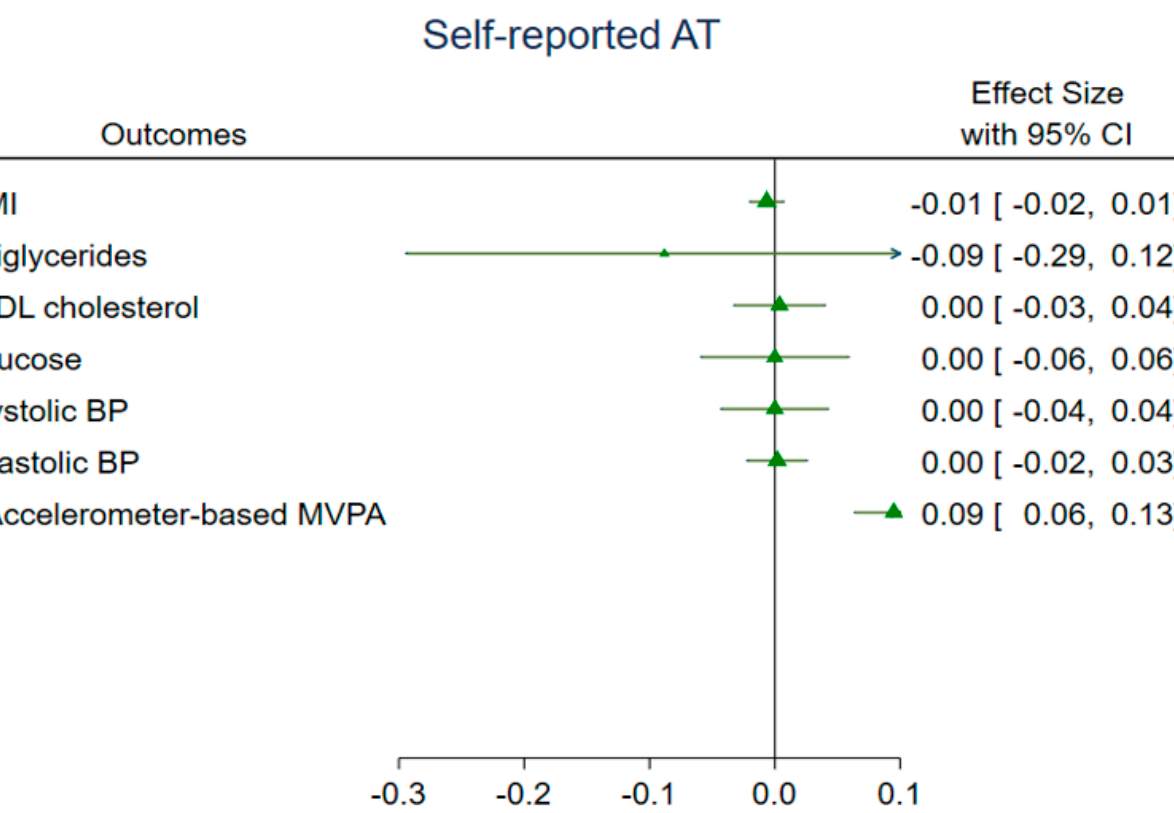
Figure 2. Adjusted associations between self-reported AT (min/day) and CVD risk factors.